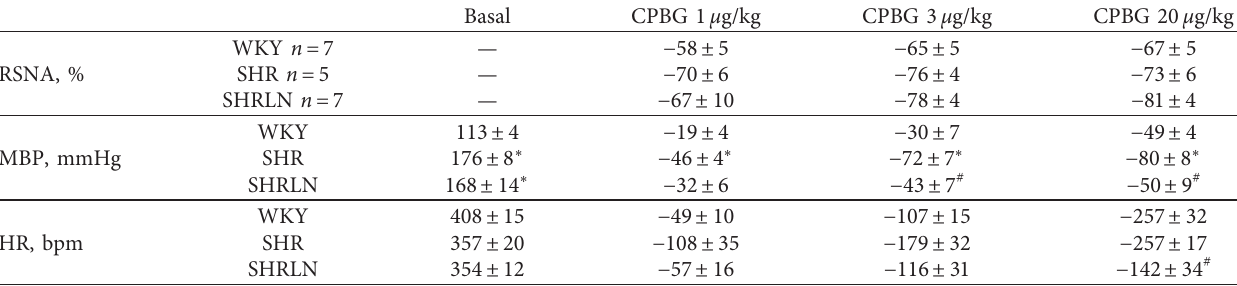
Table 2: Bezold–Jarisch reflex data.